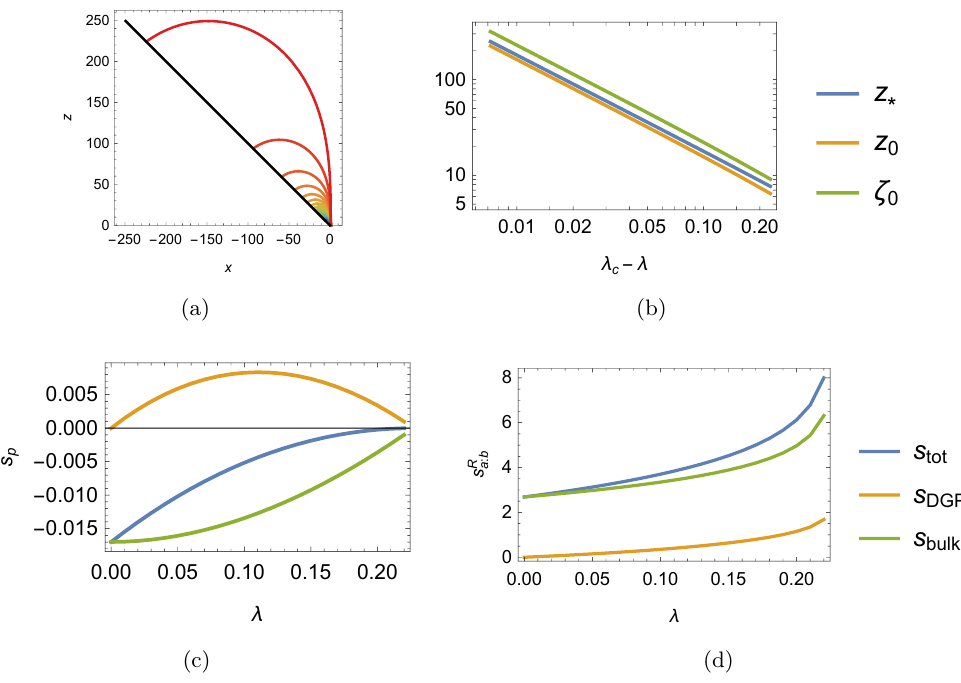
Figure 3 . (a) The RT surface for λ = 0 , 0 . 01 , 0 . 02 , . . . , 0 . 22 (from the bottom to the top) in AdS 4 . (b) z as functions of λ ∗ , z 0 , ζ 0 are renormalized by subtracting (cid:15) − n /n . The parameters are d = 3 , θ = π/ 4 , x determine λ = 0 . 227 c